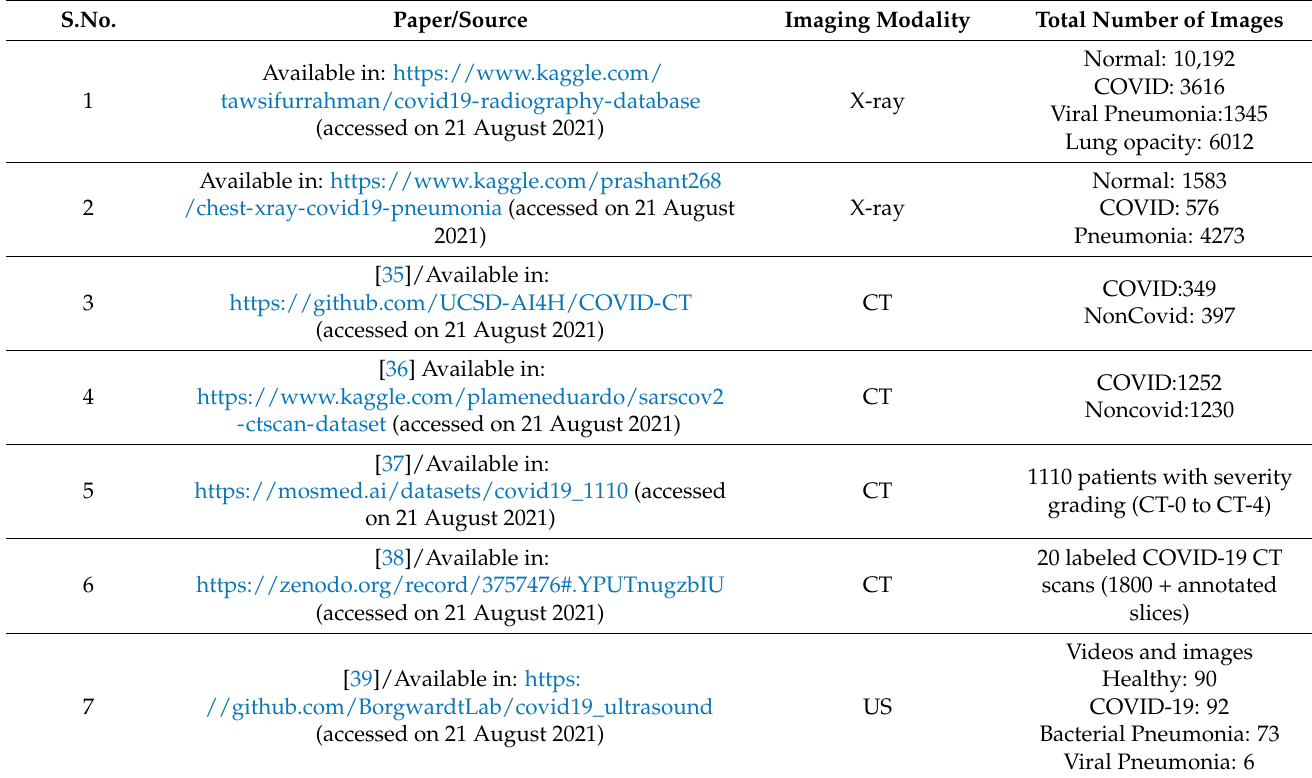
Table 1. Summary of frequently used publicly available datasets for the detection of COVID-19.